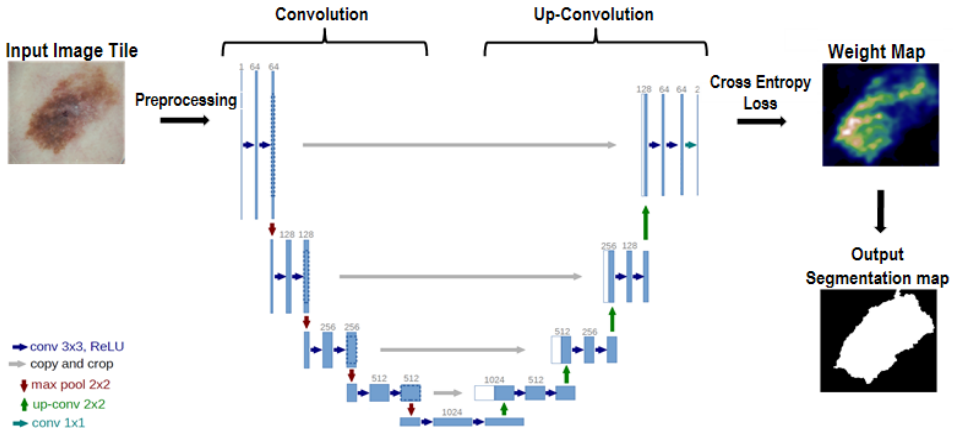
Figure 5. Structure and processing procedures of U-Net.